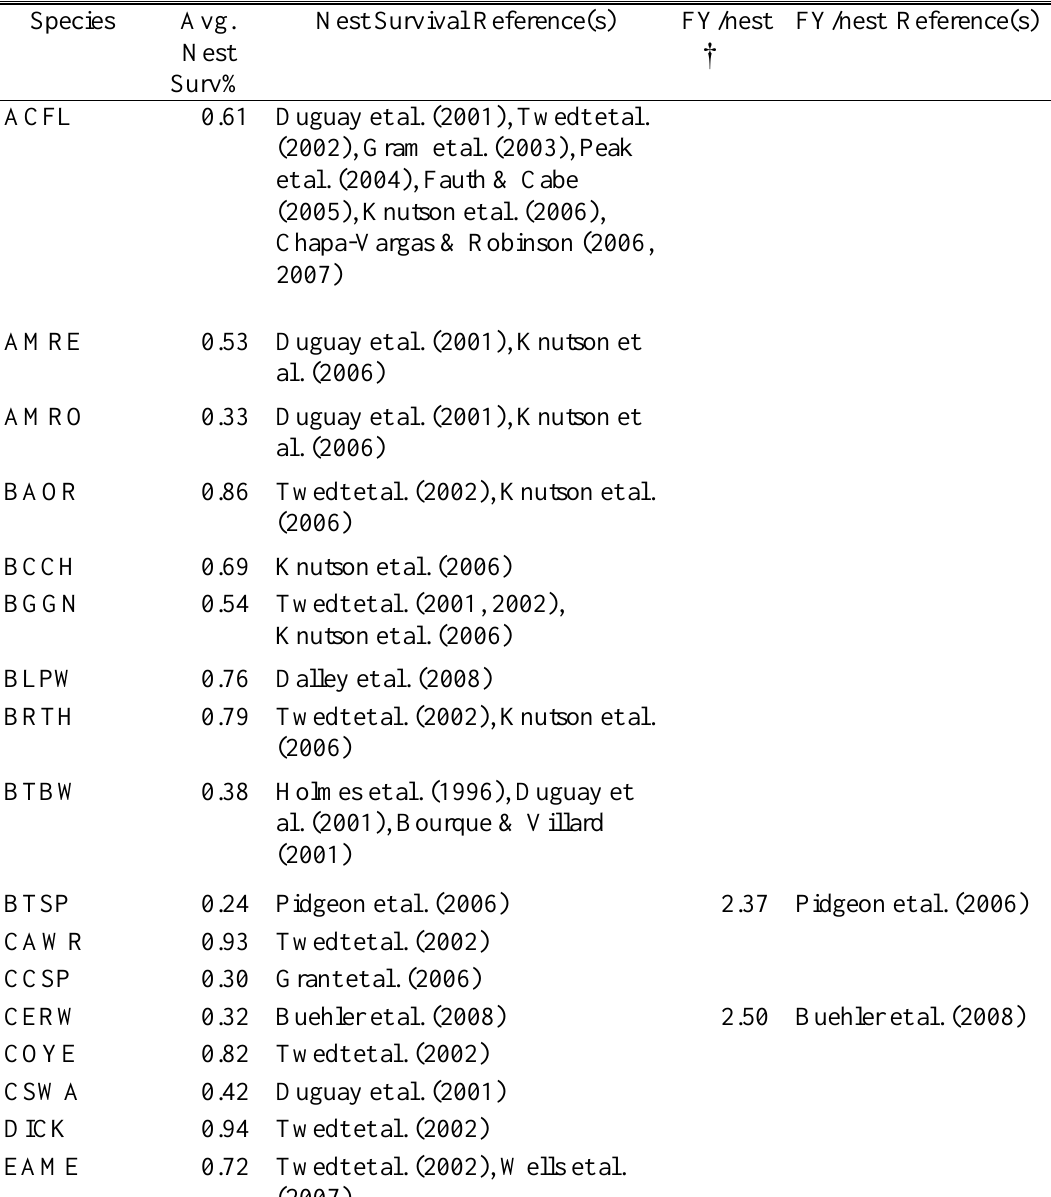
Table A3.1. Peer-reviewed sources of songbird demographic parameters used in incidental take estimates and mean estimates across studies. Species codes are according to the AOU 2012 (Pyle and De Sante 2012). Note: estimates used in the Monte Carlo simulation model corresponded to values from individual studies, not the summary data presented